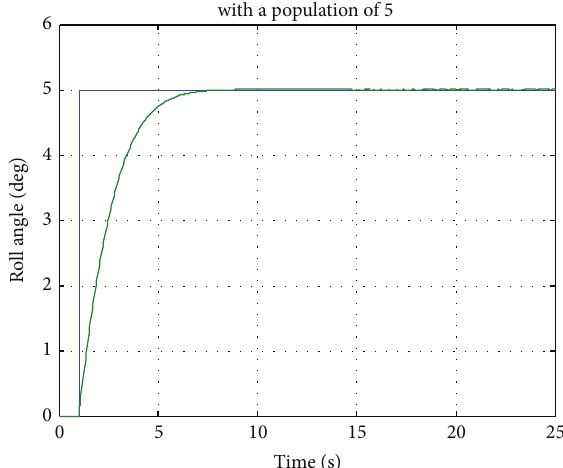
Figure 5: 𝜙 versus 𝑎 𝑦 error transient response for GA tuned PID